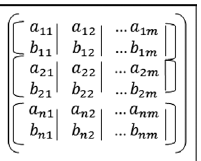
Figure 5. Quantum Representation of MSA.